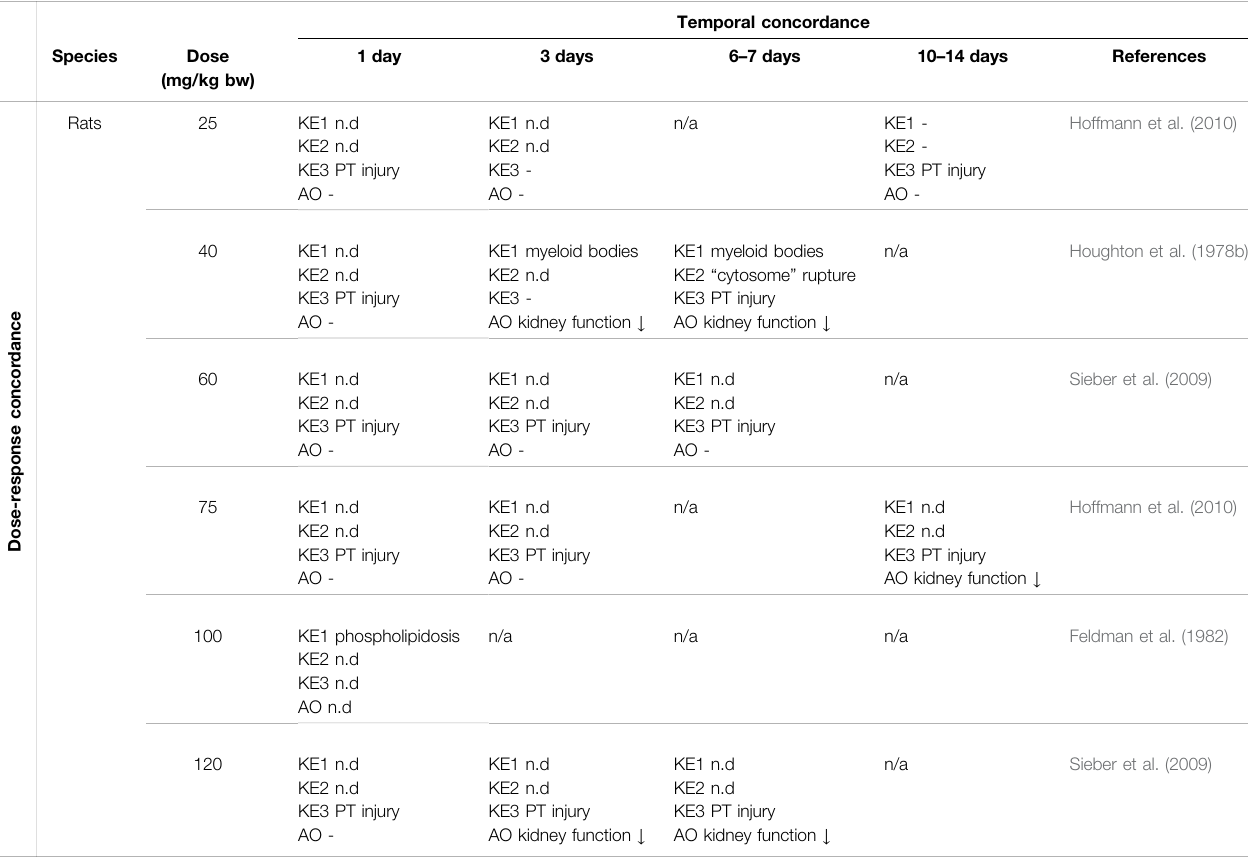
TABLE 6 | Dose-Time Concordance of KEs based on rodent studies with gentamicin as a speci fi c stressor for the adverse outcome pathway of receptor-mediated endocytosis and lysosomal overload leading to kidney toxicity (n.d. = not determined; n/a = not data available)). Temporal